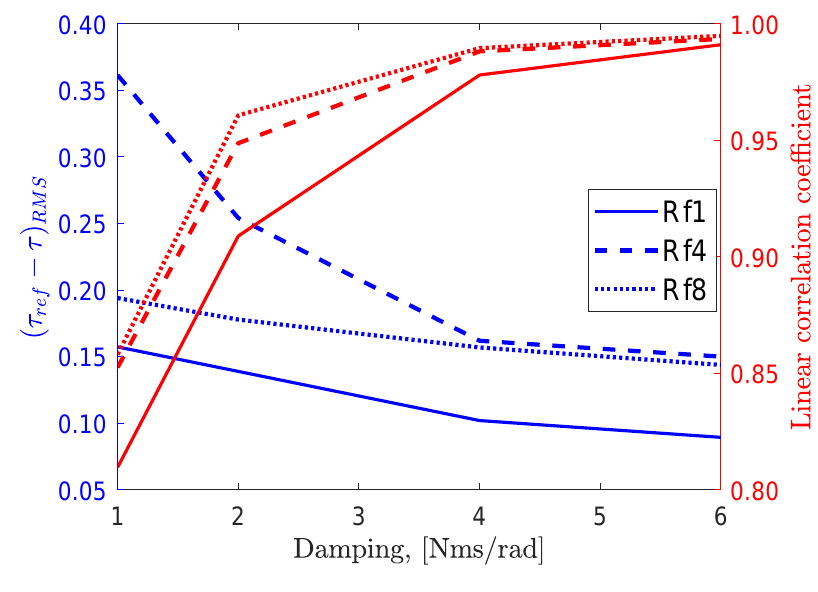
Figure 11. Machinery damping dependency of the actuator reference following capability in terms of the RMS of ( τ ref − τ ) and in terms of linear correlation coefficient between τ ref and τ , for Setup